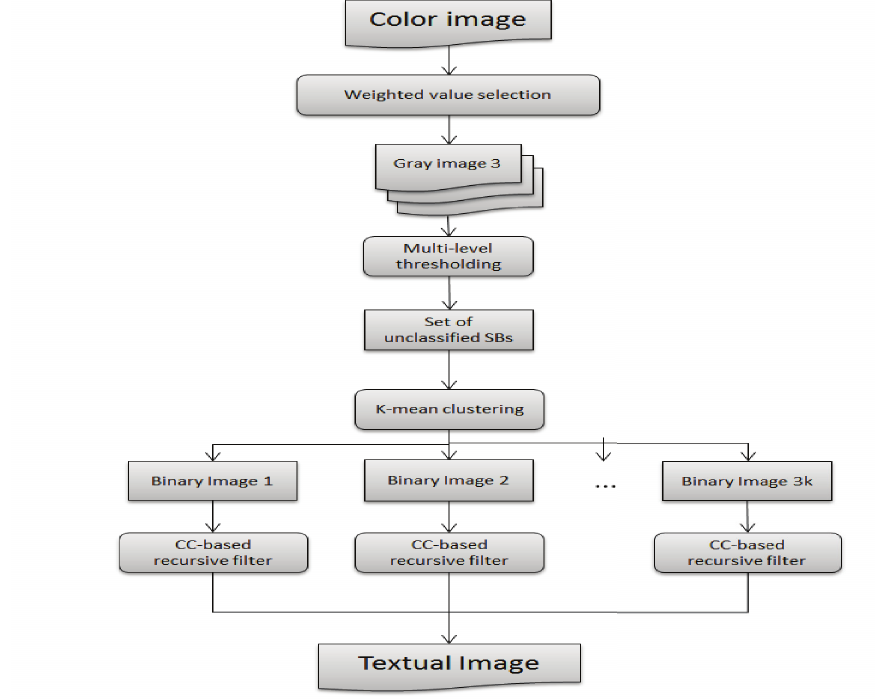
Figure 1: Flowchart of our proposed